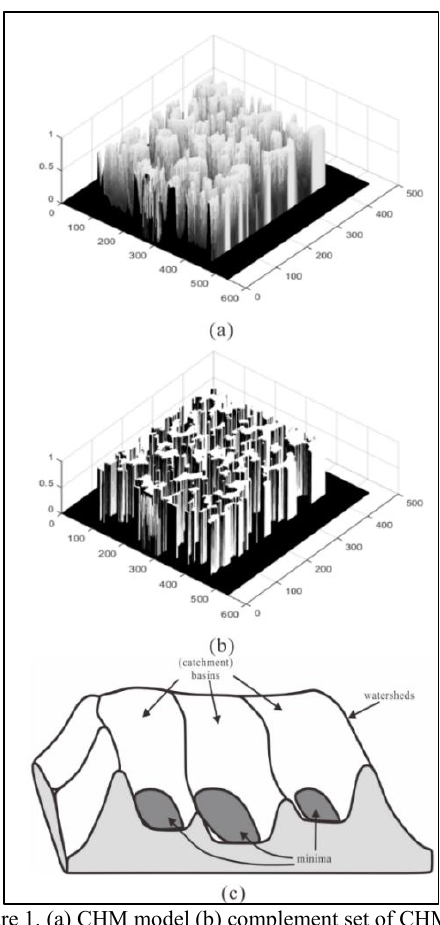
Figure 1. (a) CHM model (b) complement set of CHM (c) Watershed algorithm (Courtesy of Bernhard Preim, Charl Botha